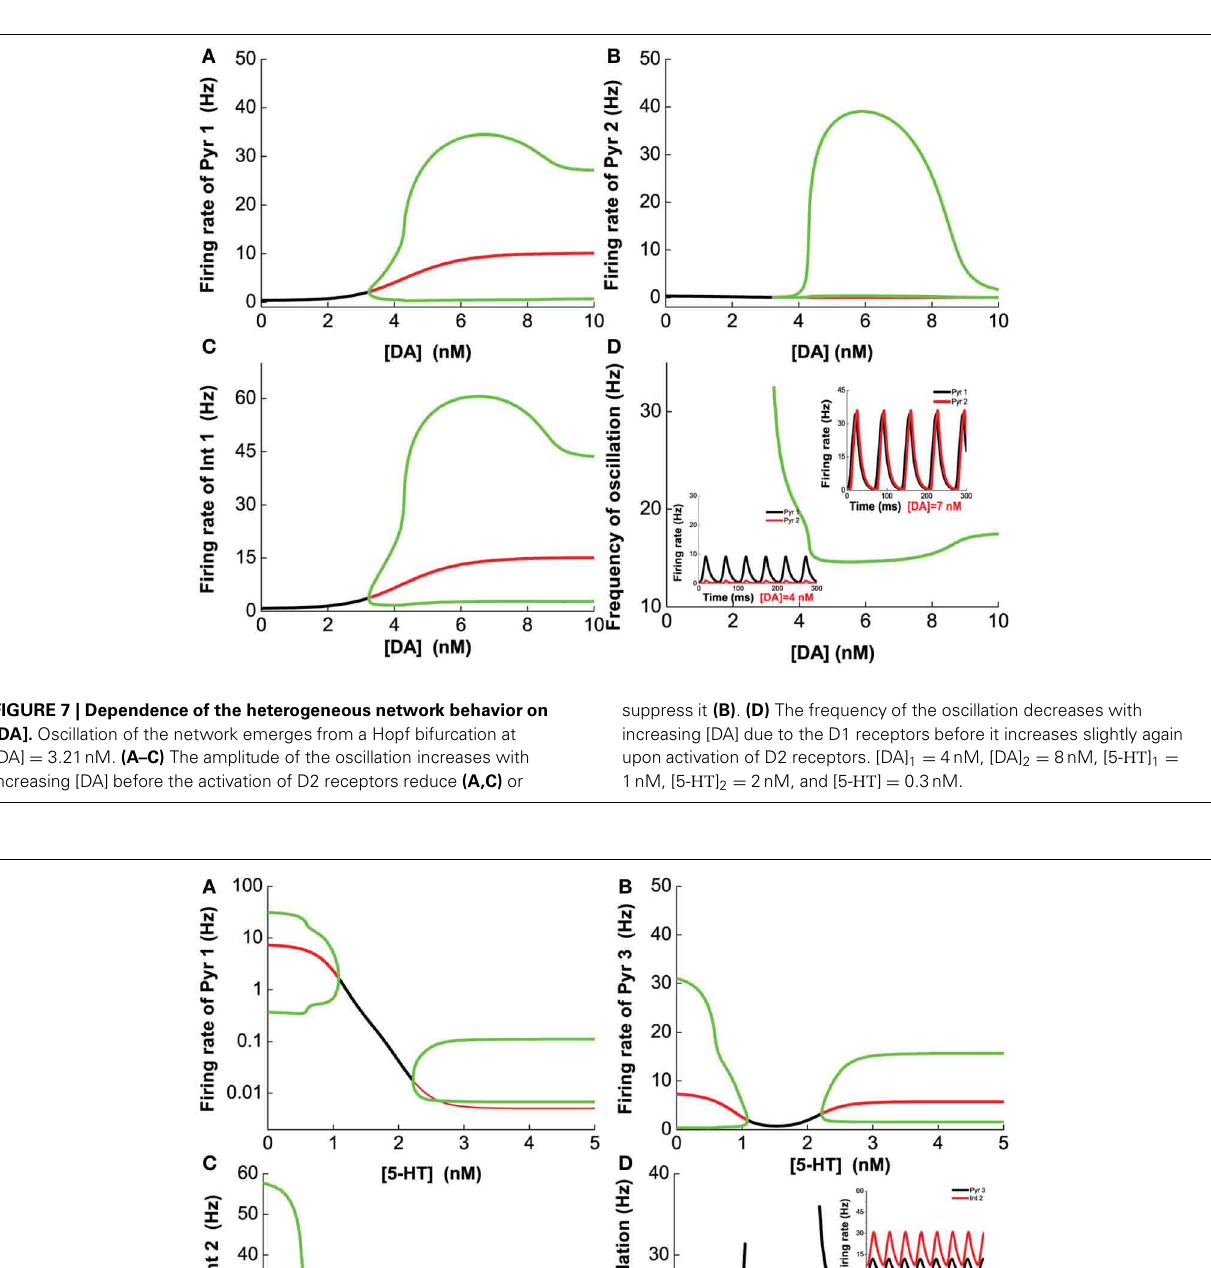
FIGURE 8 | Dependence of the heterogeneous network behavior on [5- HT ]. The network oscillates only for low [5- HT ] ( < 1.08nM) or high [5- HT ] ( > 2.22nM). (A) Activity of pyramidal cells expressing 5-HT1A is almost totally suppressed by the activation of 5-HT1A when [5- HT ] exceeds [5- HT ] 1 (note: log scale). (B) Activity of pyramidal cells